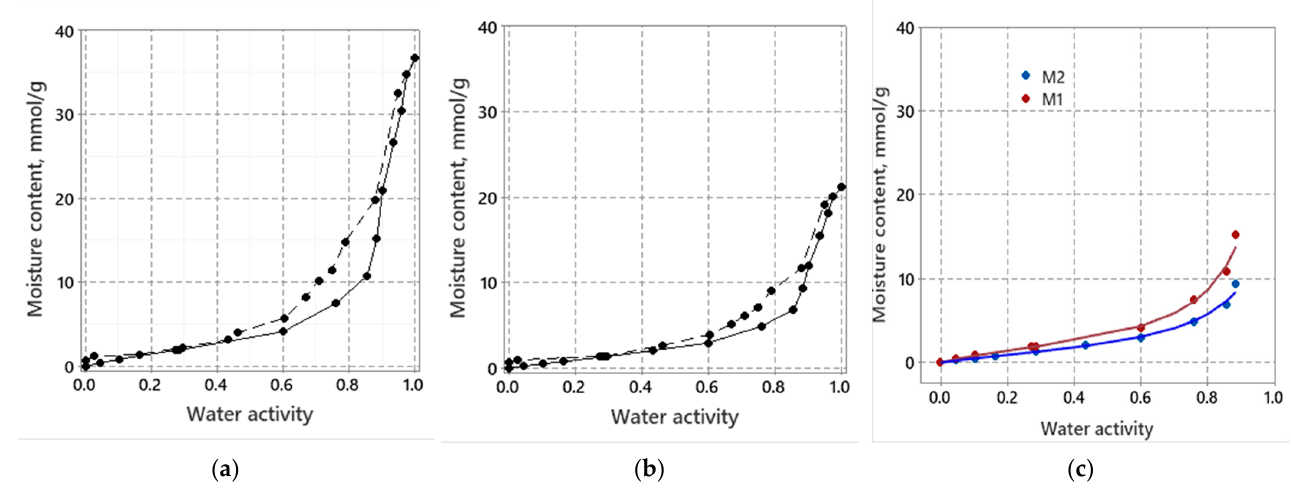
Figure 1. Moisture isotherm adsorption (solid line) and desorption (dashed line) of muffins: ( a ) sample M1; ( b ) sample M2; ( c ) fit of the experimental moisture isotherm (dot) of muffins by the GAB equation (solid line).